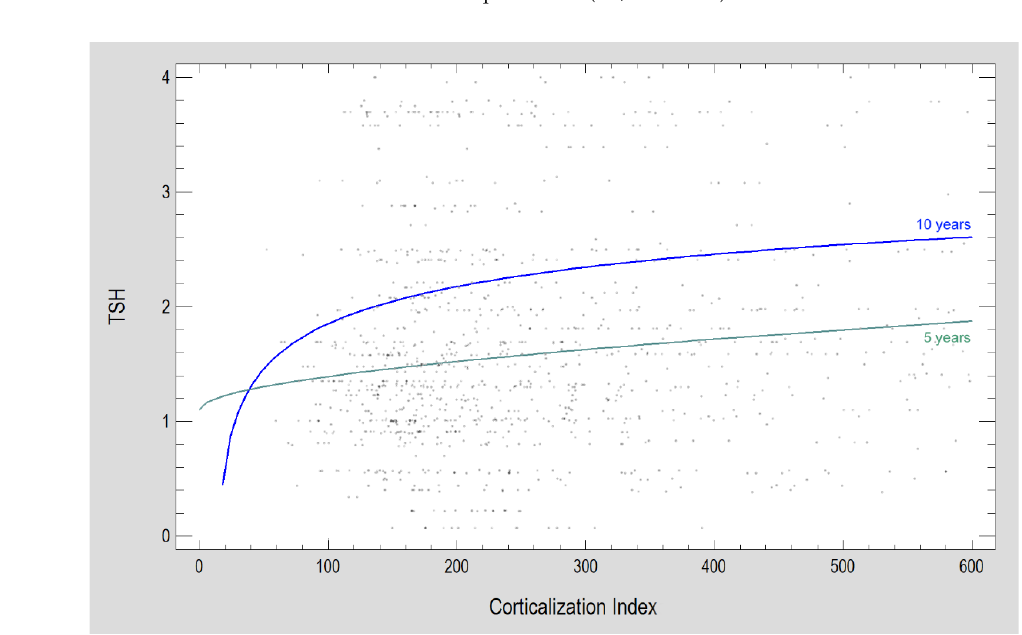
Figure 4. An example of the relationship found between patients’ general condition (TSH: thyrotropin serum level in mU/L) and the corticalization index. Both relationships are statistically significant ( p < 0.05).